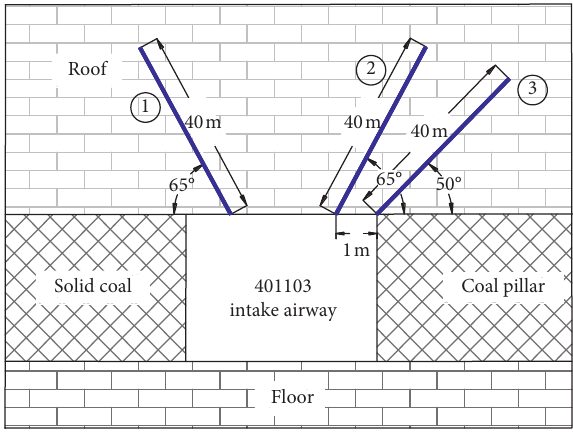
Figure 6: Sketch map of presplitting blast in